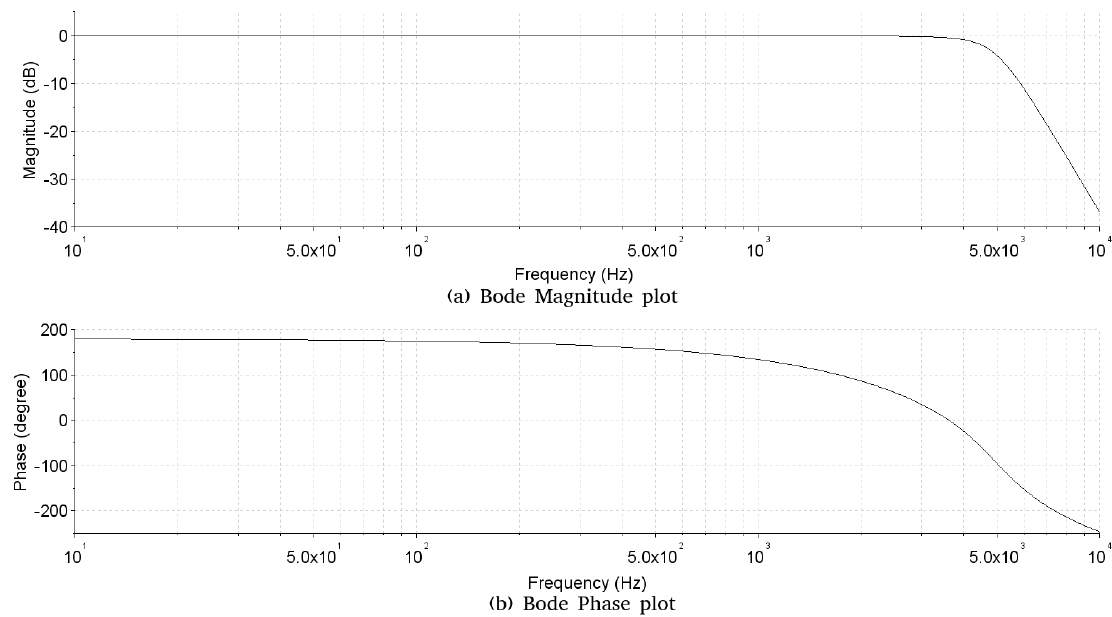
Figure 8. Bode diagram, with the Bode Magnitude plot (a) and the Bode Phase plot (b), of analog of analog low-pass filter